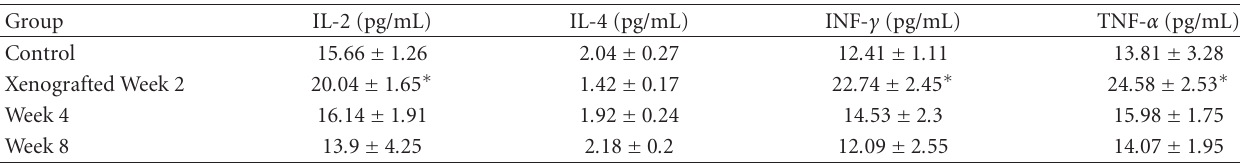
Table 1: Serum levels of cytokines in xenograft recipients. Eight animals were analyzed at each time point and data are presented as mean ( ±